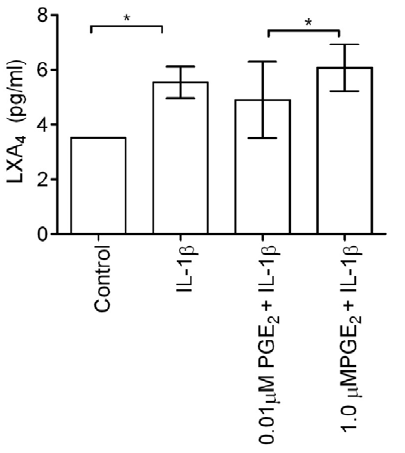
Figure 8. Mean LXA 4 levels 24 hours after stimulation with pro- inflammatory mediators. Explants were derived from macroscopi- cally normal tendons from 3 horses aged between 9–14 years of age and stimulated with 5 ngml 2 1 IL-1 b or combined stimulation with low (0.01 m M) or high (1.0 m M) doses of PGE 2 with 5 ngml -1 IL-1 b compared to non-stimulated controls. LXA 4 release was increased in all stimulated samples compared to respective controls ( P =0.005). Treatment with IL- 1 b induced greater LXA 4 production compared to controls ( P =0.011). Combined stimulation with high dose PGE 2 enhanced LXA 4 release compared to low dose PGE 2 ( P =0.032). Error bars represent standard deviation. * P , 0.05.